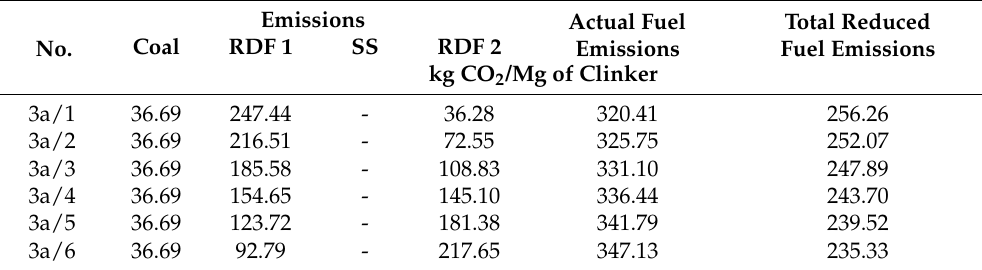
Table 7. The CO 2 emissions balance of blends of coal with RDF 1-RDF 2 (3a—three components).